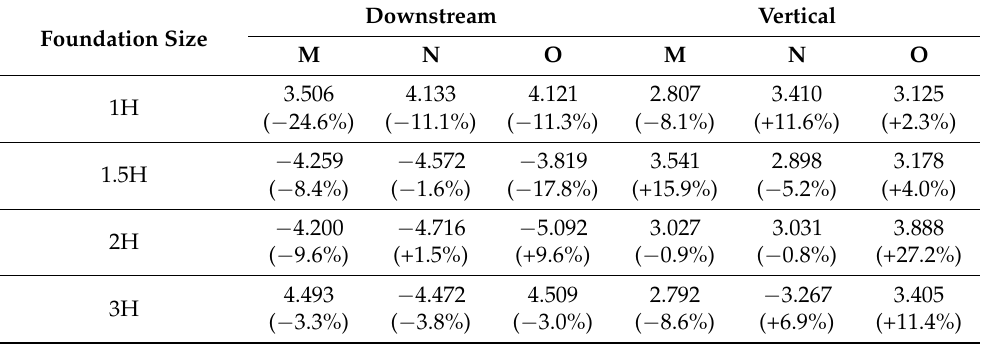
Table 6. The PGA values at the observation points under the Koyna earthquake excitation (m/s 2